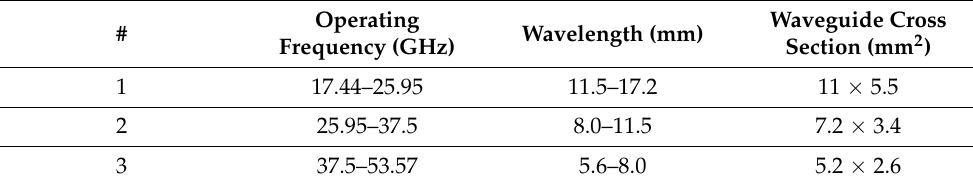
Table 6. Characteristics of measurement